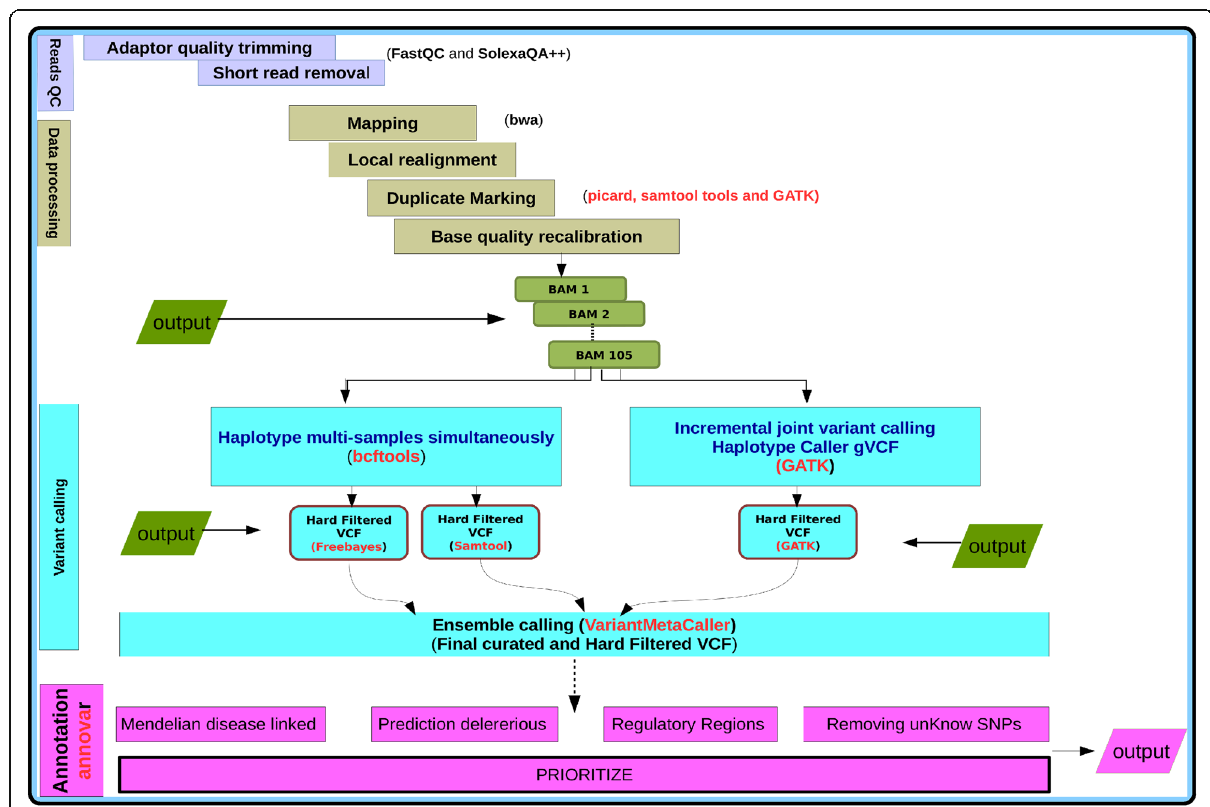
Fig. 1 Workflow of the data analysis. Describes the bioinformatics pipelines from alignment of DNA reads, variants calling to in silico mutation prioritization